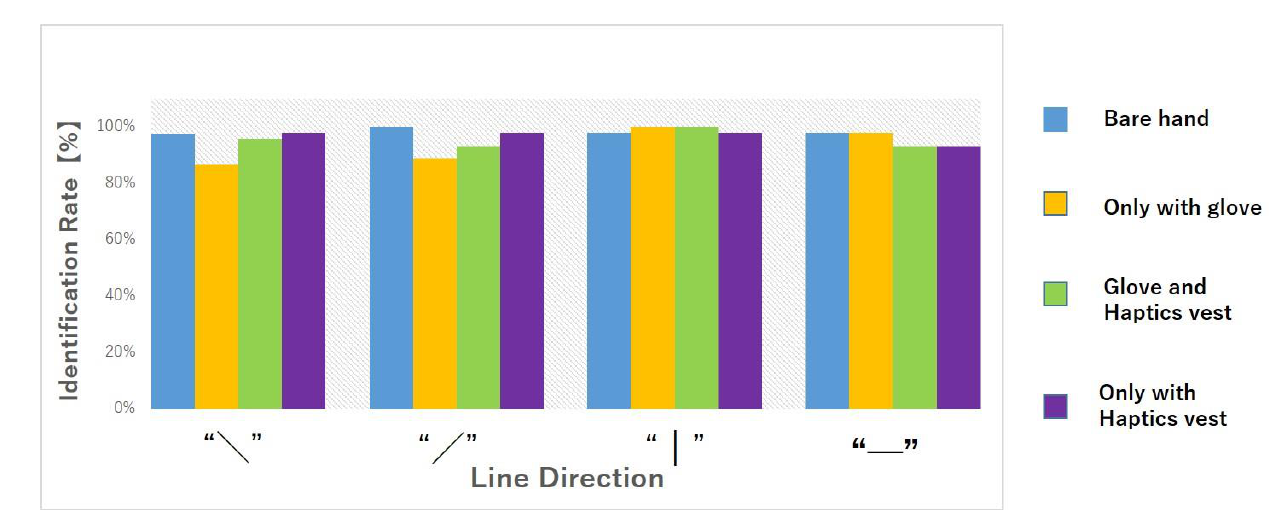
Figure 11. Identification rate of object shape under each scenario.